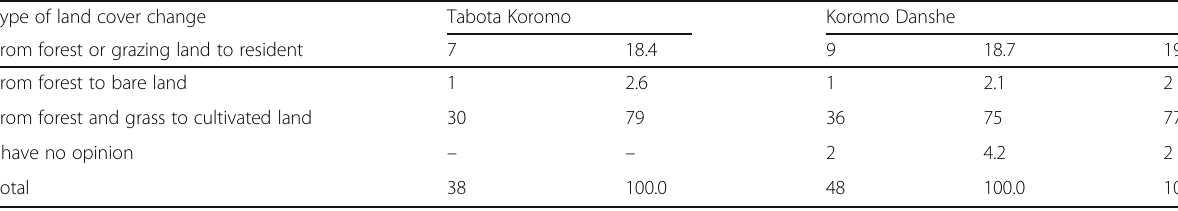
Table 3 Awareness of the people on land cover change of the area Type of land cover change